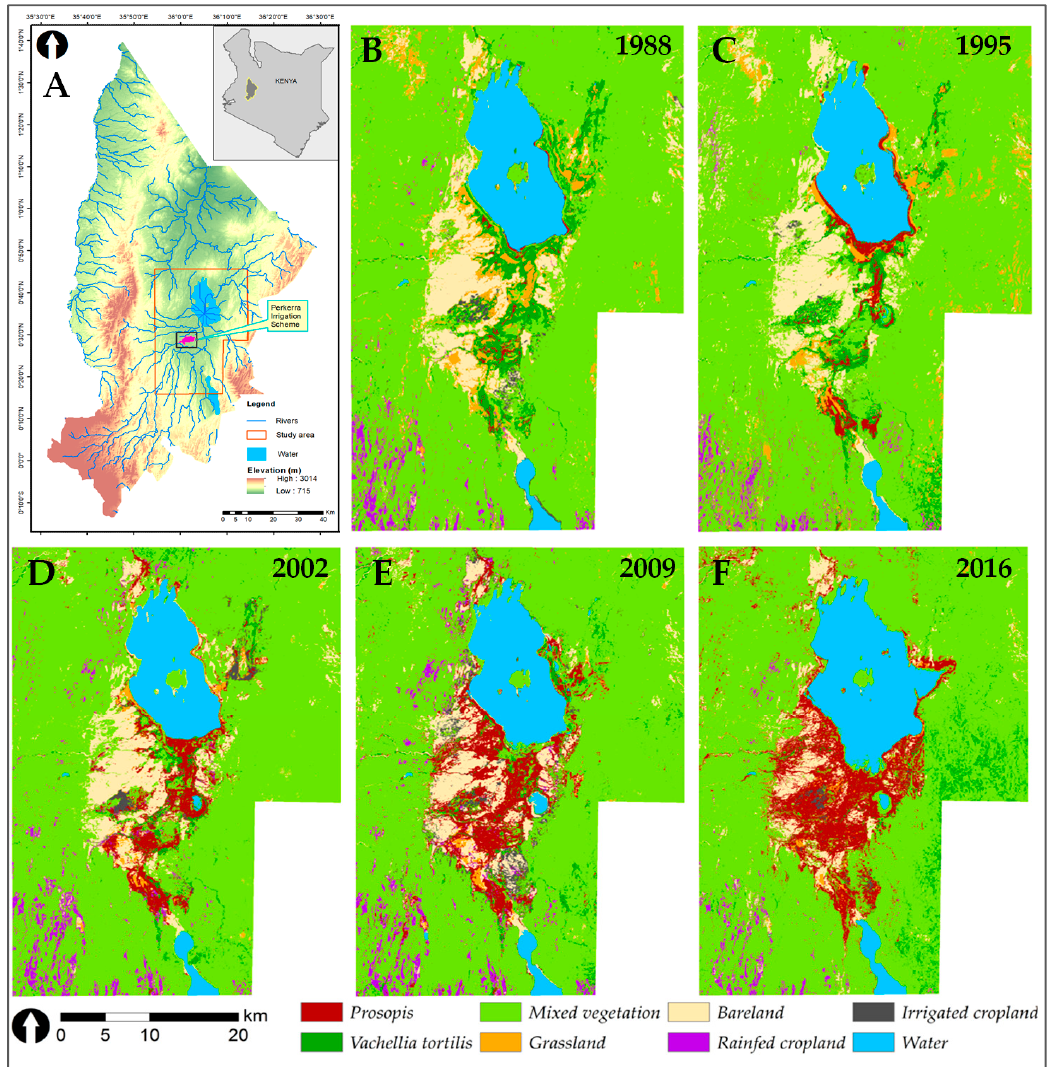
Figure 2. Overview map ( A ) and LULC maps ( B – F ) of the Marigat subregion, Baringo County, Kenya, for the years 1988, 1995, 2002, 2009, and 2016. The overview map shows the topography, waterways, lakes, and the Perkerra irrigation scheme. The red boundary zone is the extent of the study area.